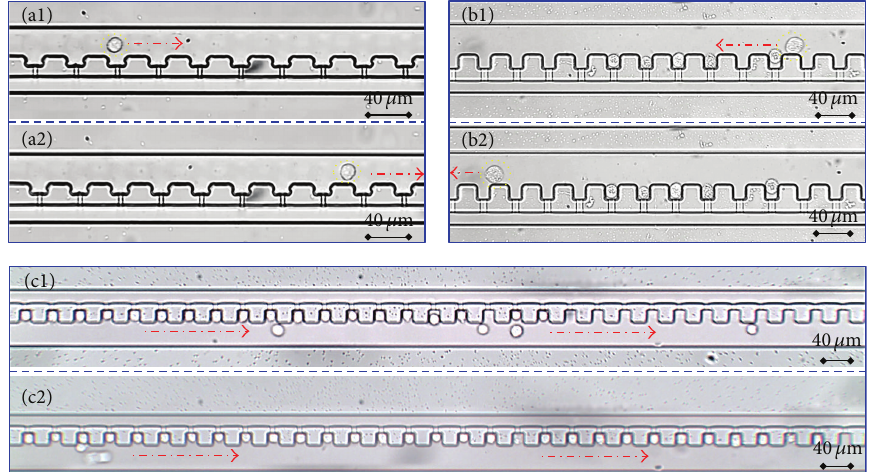
Figure 5: Experimental results of cellular trapping. (a) A cell under gravity was noticed to travel in the main channel without being trapped in cellular trapping spots, indicating that cellular loading cannot be realized based on gravity due to the low flow rate. (b) A coming larger cell travelled along the main channel without taking trapping sites while smaller cells were trapped in the trapping positions. These results indicated that the trapping device is sensitive to cell sizes. (c) After optimization, almost all the trapping sites were taken by individual cells. Note that pictures labelled as 1 and 2 ((a1) versus (a2), (b1) versus (b2), and (c1) versus (c2)) represent two images of the same location taken in a time sequence